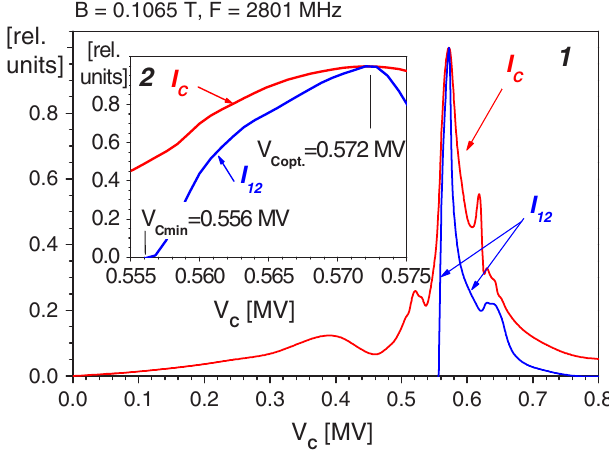
FIG. 2. (Color) Normalized amplitudes of the loading current, I , and the accelerated current extracted from 12th orbit, I 12 , C versus the accelerating voltage. In the inset, (2), the curves I and I 12 are plotted in detail in the neighborhood of the microtron operating